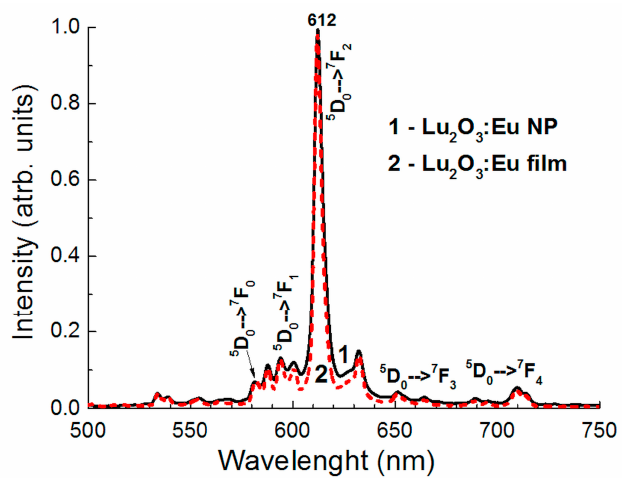
Figure 4. Cathodoluminescence (CL) spectra of Lu 2 O 3 :Eu nanopowder (NP) (1) and film (2) samples at room temperature (RT).